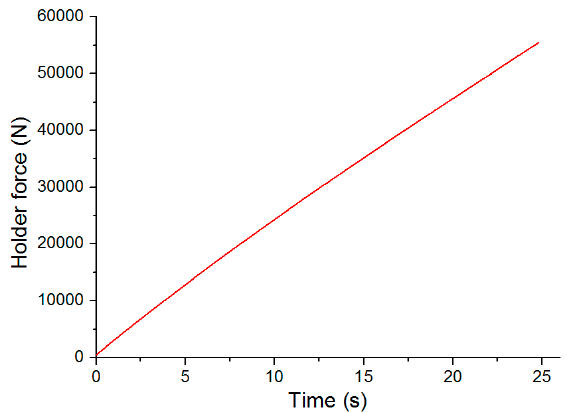
Figure 3. Improved clinching tools: ( a ) dies; ( b ) main geometrical parameters.